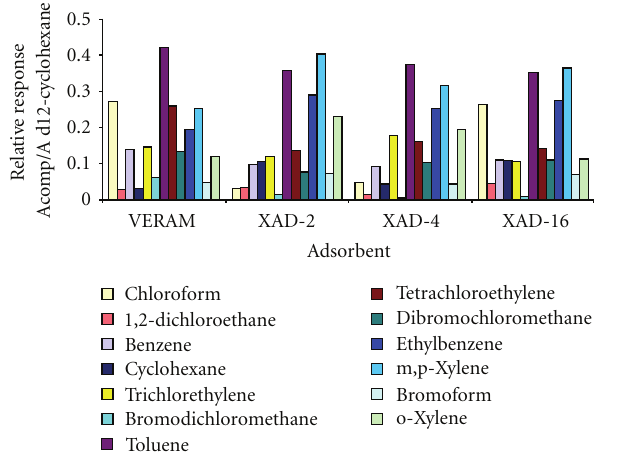
Figure 4: Relative response of VOCs in membranes deployed for 72h and filled with di ff erent adsorbent Amberlite materials ( n = 3).